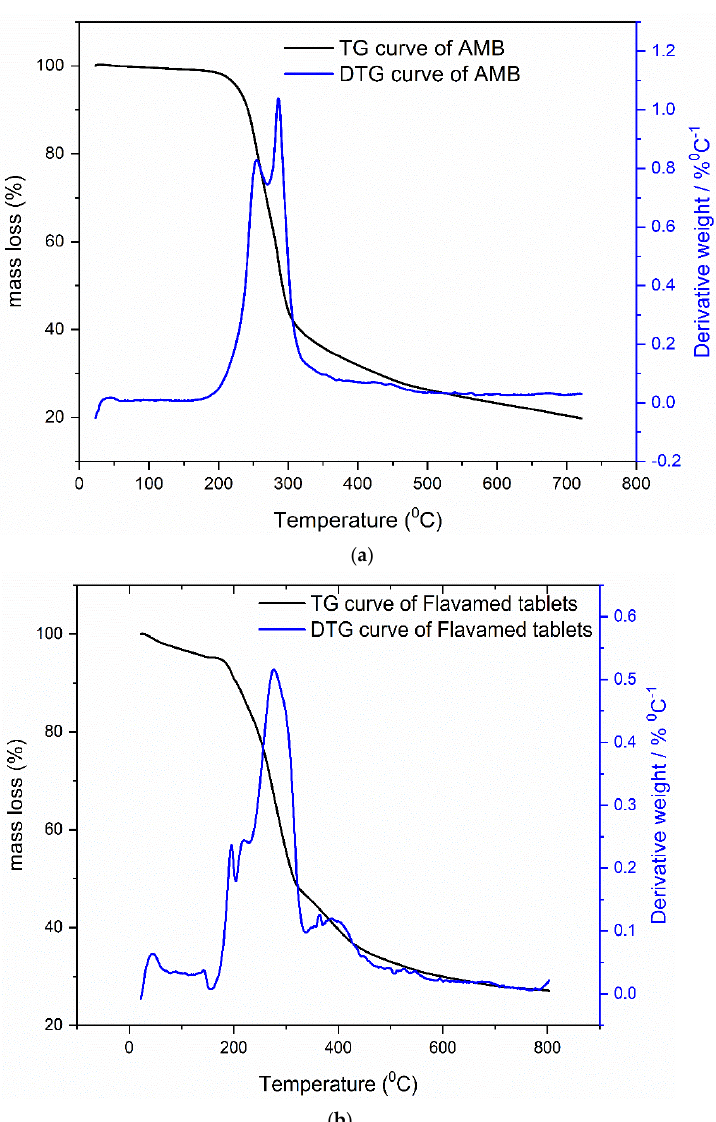
Figure 2. ( a , b ) The simultaneously TG/DTG curve of ambroxol hydrochloride and Flavamed ® tablet formulation at β = 10 °C/min in N 2 atmosphere .